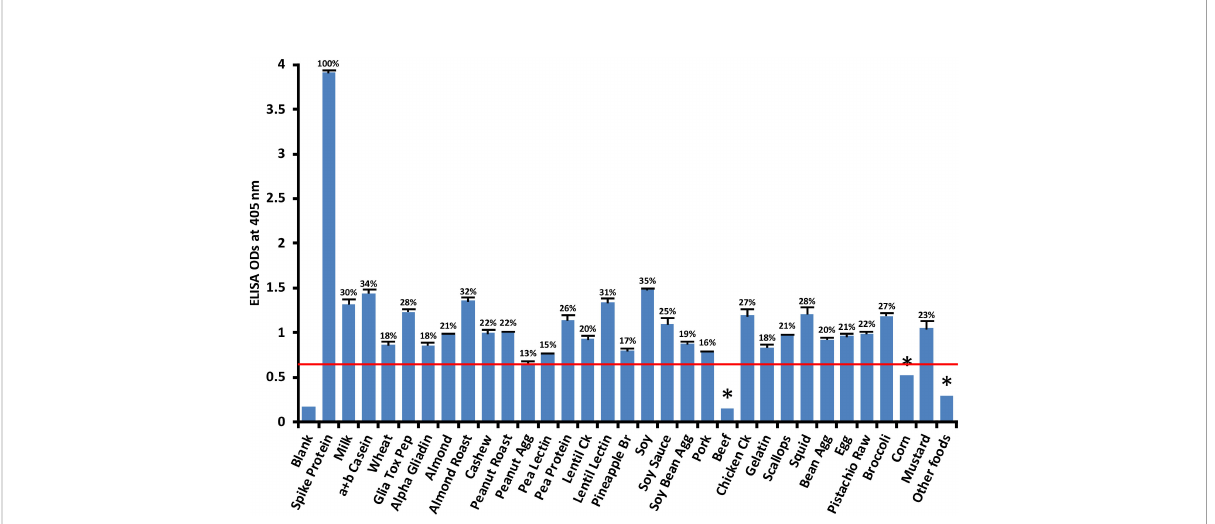
FIGURE 3 Reaction of human SARS-CoV-2 spike protein monoclonal antibody with various food antigens. At 3SD above the OD of antibody reaction with non-reactive foods or OD of 0.56, the spike protein antibody reacted signi fi cantly with 28 out of 180 tested food proteins and peptides. These reactions of SARS-CoV-2 spike protein antibody with different food antigens was obtained from quadruplicate testing. The SDs for all the reactions were less than 0.1, and are shown as error bars. * = Antigens whose reactions were under the cutoff and/or close to the blank. Glia Tox Pep, Gliadin Toxic Peptide; Peanut Agg, Peanut Agglutinin; Soy Bean Agg, Soy Bean Agglutinin; Bean Agg, Bean Agglutinin; Pineapple Br, Pineapple Bromelain; Ck,